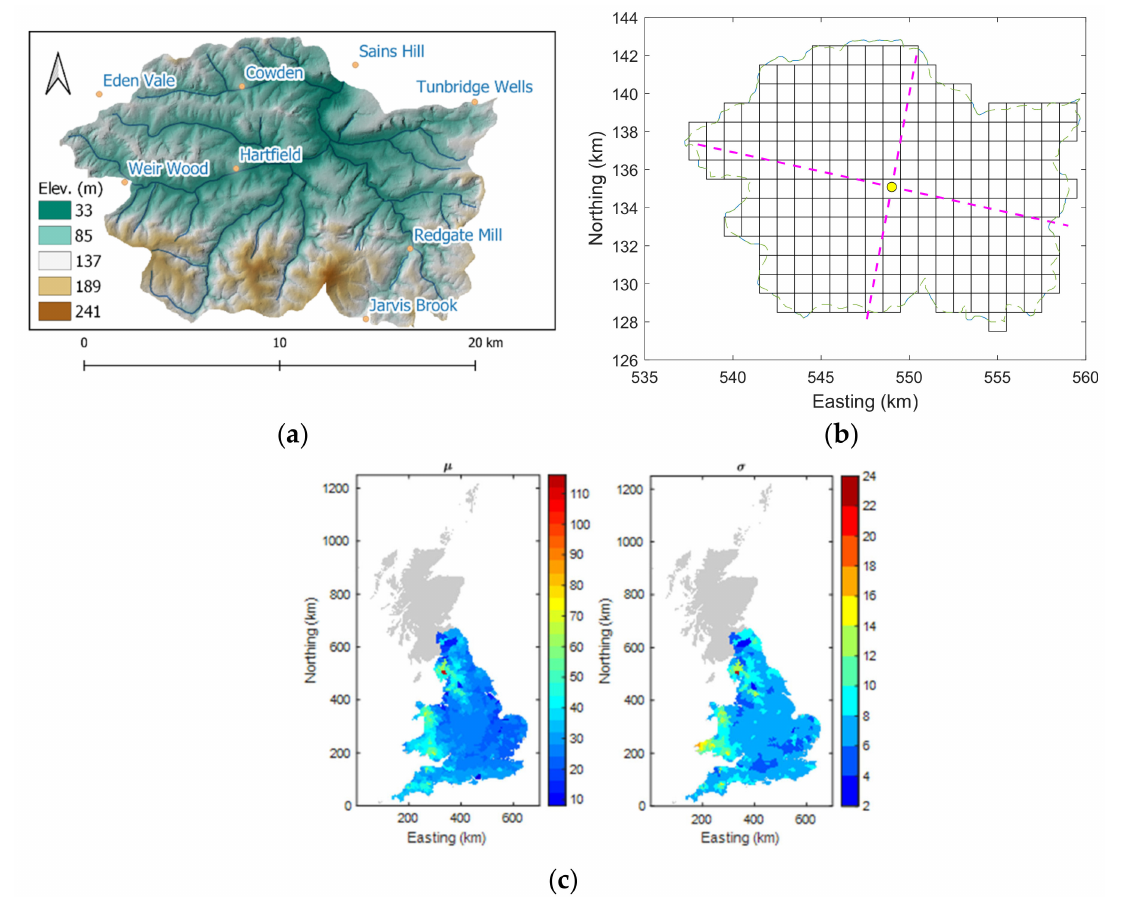
Figure 4. Topographic and the river network map of the Upper Medway Catchment ( a ) and its spatial features (geographic location, size, orientation and shape) detected by the SPER toolbox ( b ) and spatial variation of parameters µ and σ of the GEV distribution for all catchments ( c